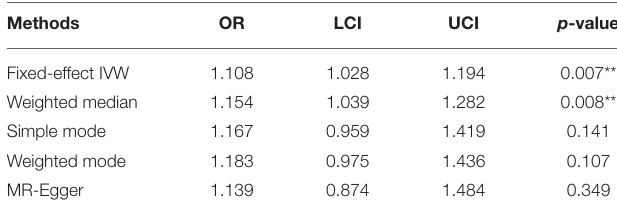
TABLE 2 | Association of HI with falls risk using various